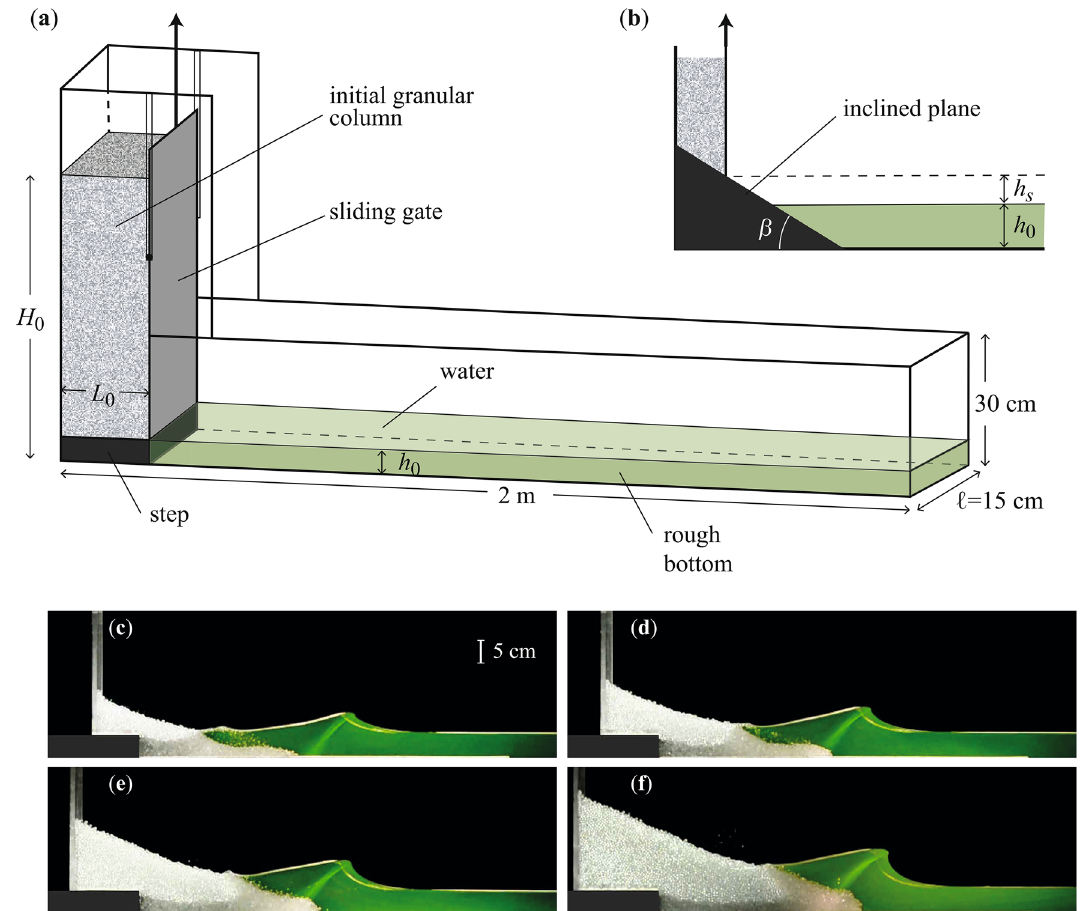
Figure 1. Sketch of the experimental setup for the gravity-driven collapse of initially dry grains over ( a ) a horizontal bottom (setup I) or ( b ) an inclined plane (setup II) into a water layer of depth h 0 within a rectangular tank of width ℓ . ( c–f ) Pictures showing the maximal wave generated by the collapse of an initial column of 5 cm water 2.5 with different volume V g of glass beads ( d 5 mm , ρ g 2.5 g / cm 3 ) in a h 0 aspect ratio a = = = = 2.0 ), ( d ) V g 2.3 ), ( e ) V g 2.5 ), and ( f ) 2.0dm 3 ( Fr 0 3.3dm 3 ( Fr 0 4.9dm 3 ( Fr 0 layer for ( c ) V g ≃ ≃ ≃ = = = 2.8 V g 7.8 dm 3 ( Fr 0 ≃ =